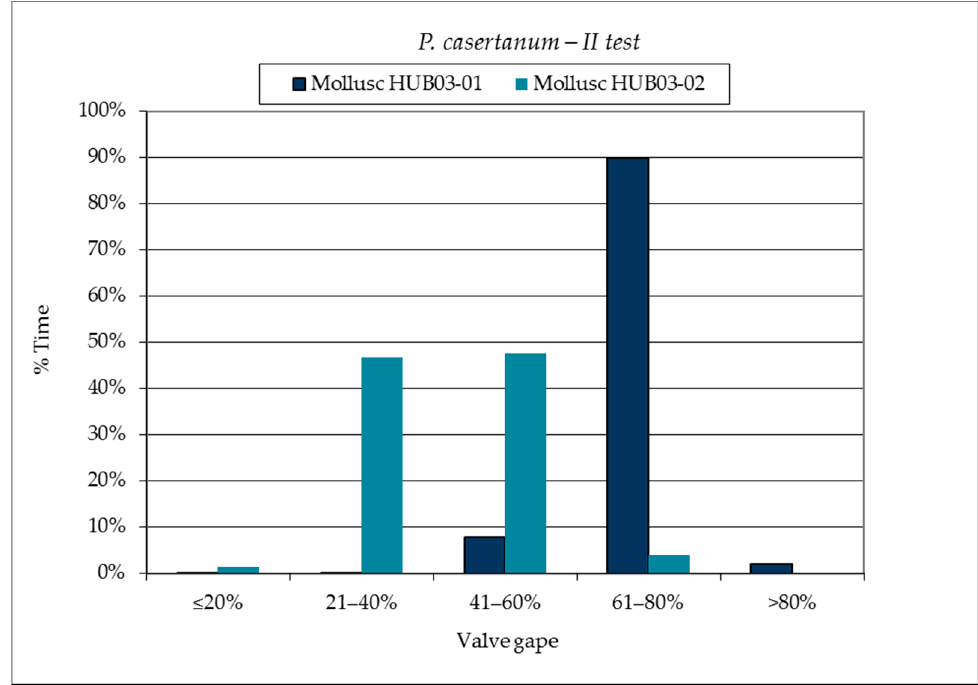
Figure 13. Average percentage of time spent in established valve gape ranges by molluscs in the second study group, from 5 to 28 July 2018. Valve gapes is reported as % of valve openings.